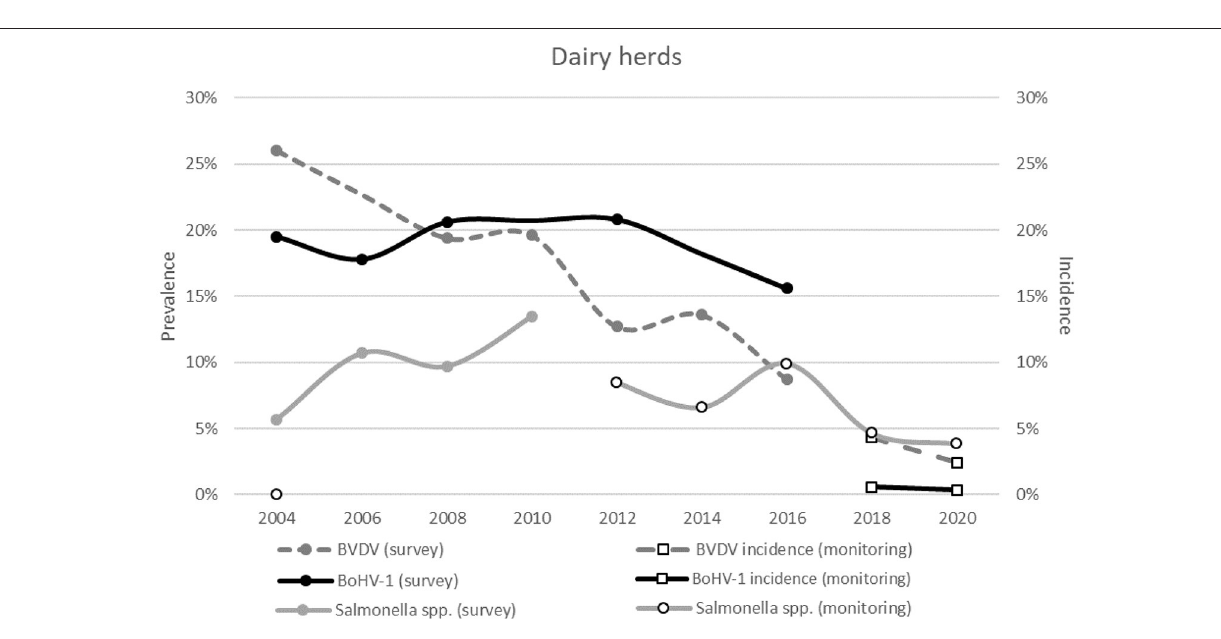
FIGURE 10 | The prevalence in surveys conducted between 2004 and 2020 for BVDV, BoHV-1 and Salmonella spp. on Dutch dairy herds. The white markers with the black border indicate the incidence or prevalence based on the national monitoring program instead of a prevalence survey. The accompanying confidence intervals are presented in Appendix 2